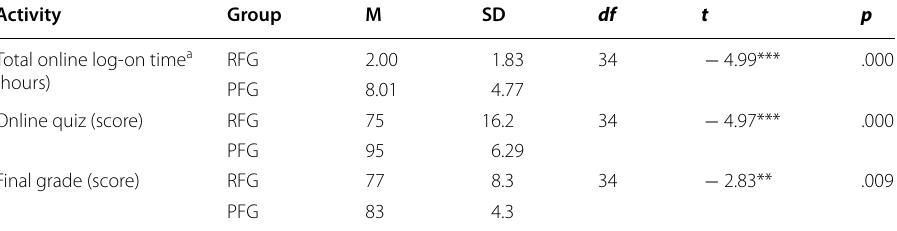
a RFG total online log-on time ** p < .01, *** p < .001